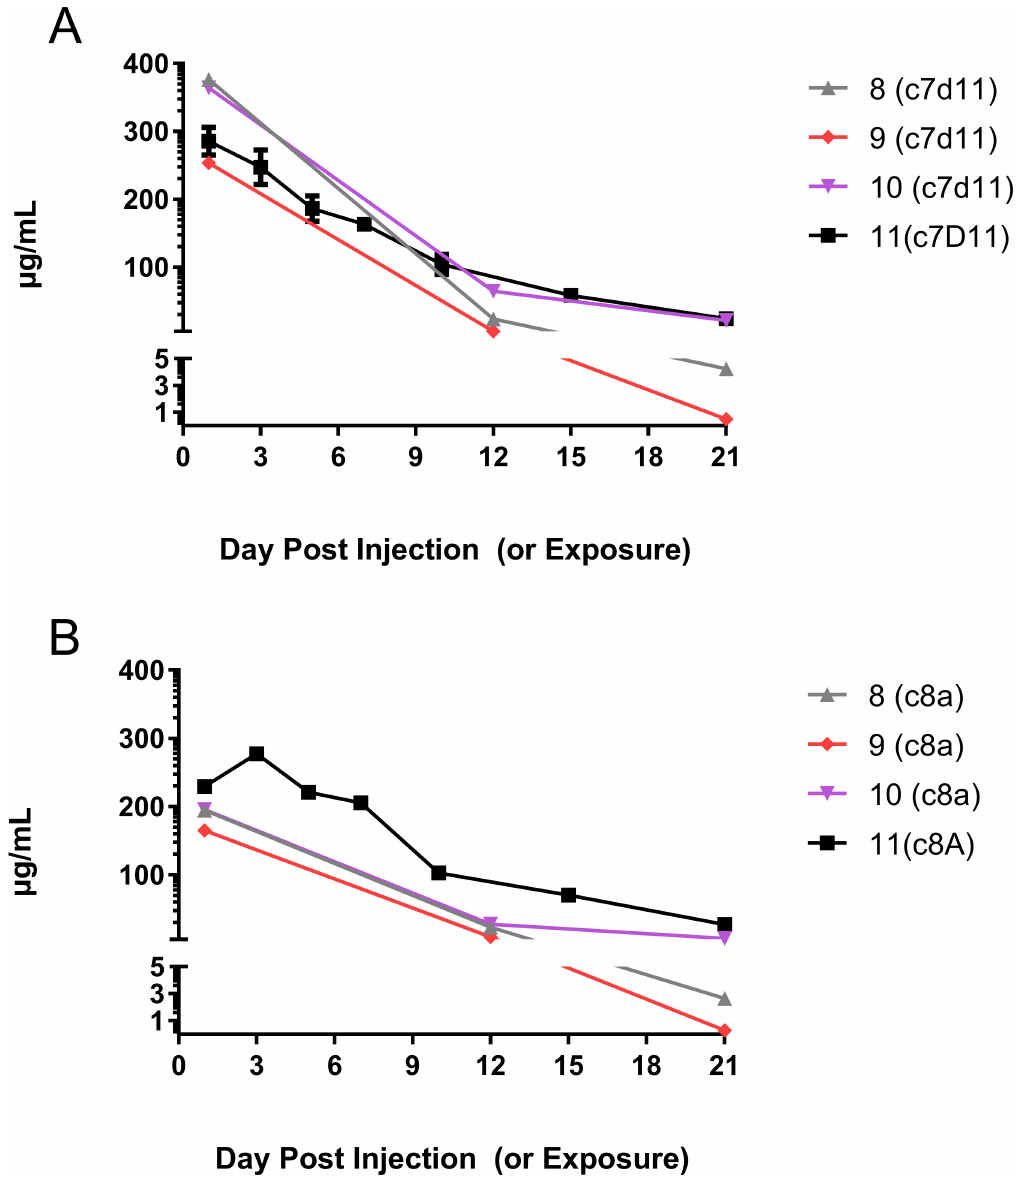
Fig 9. Levels of c8A and c7D11monoclonal antibodies in infected and uninfected marmosets. Marmosets were subcutaneously injected with a 1:1 mixture of a cocktail containing c8A and c7D1 (20mg/Kg of each antibody per animal). A single animal was not exposed to monkeypox virus (#11). Of the exposed animals, Days 1, 12 and 21 were analyzed for the presence of c7D11 (A) and c8A (B). For infected animals #8, #9 and #10, days are relative to the day of exposure. For animal #11, days are relative to subcutaneous injection of the